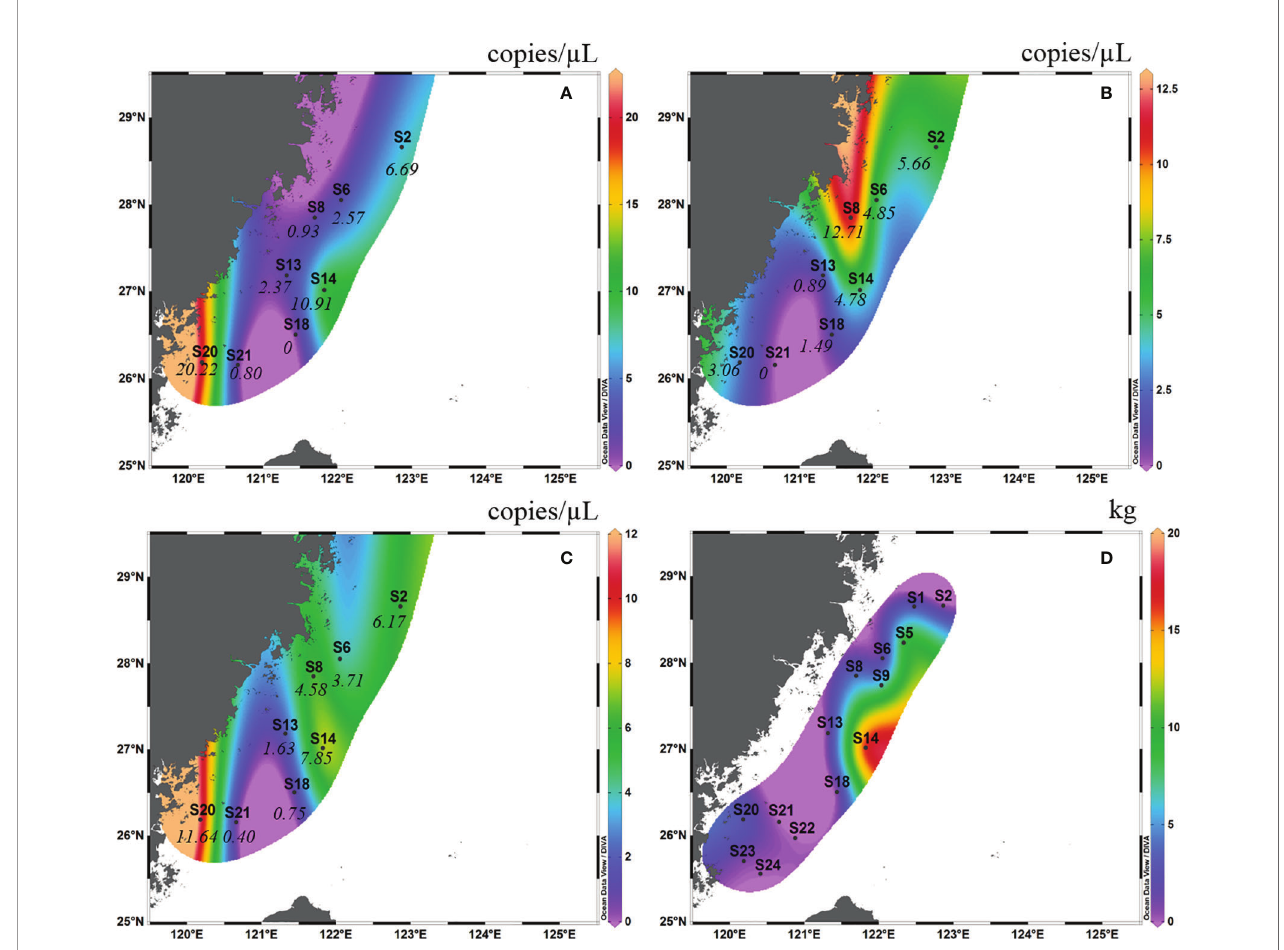
FIGURE 4 | Contour map of Larimichthys crocea in the East China Sea in autumn 2018 based on eDNA concentration of real-time qPCR analysis from surface samples (A) , bottom samples (B) and the average between surface samples and bottom samples (C) , and based on capture biomass from the fi shing survey (D) . The italicized numbers indicate the eDNA concentrations of L. crocea